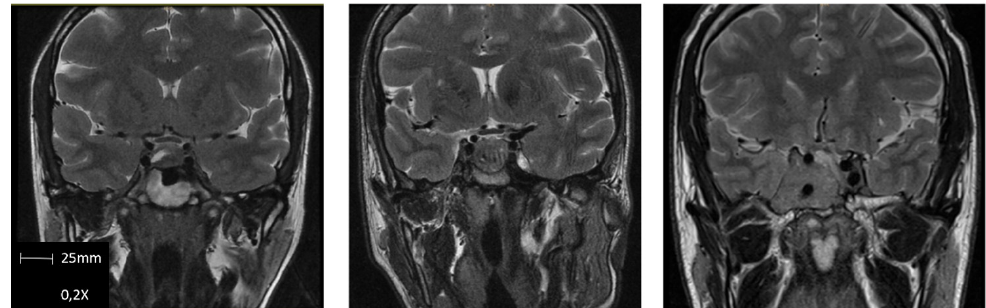
Figure 1. Examples of GH PitNET T2-weighted M.R.I. intensity classification. From left to right : Hypointense, isointense, and